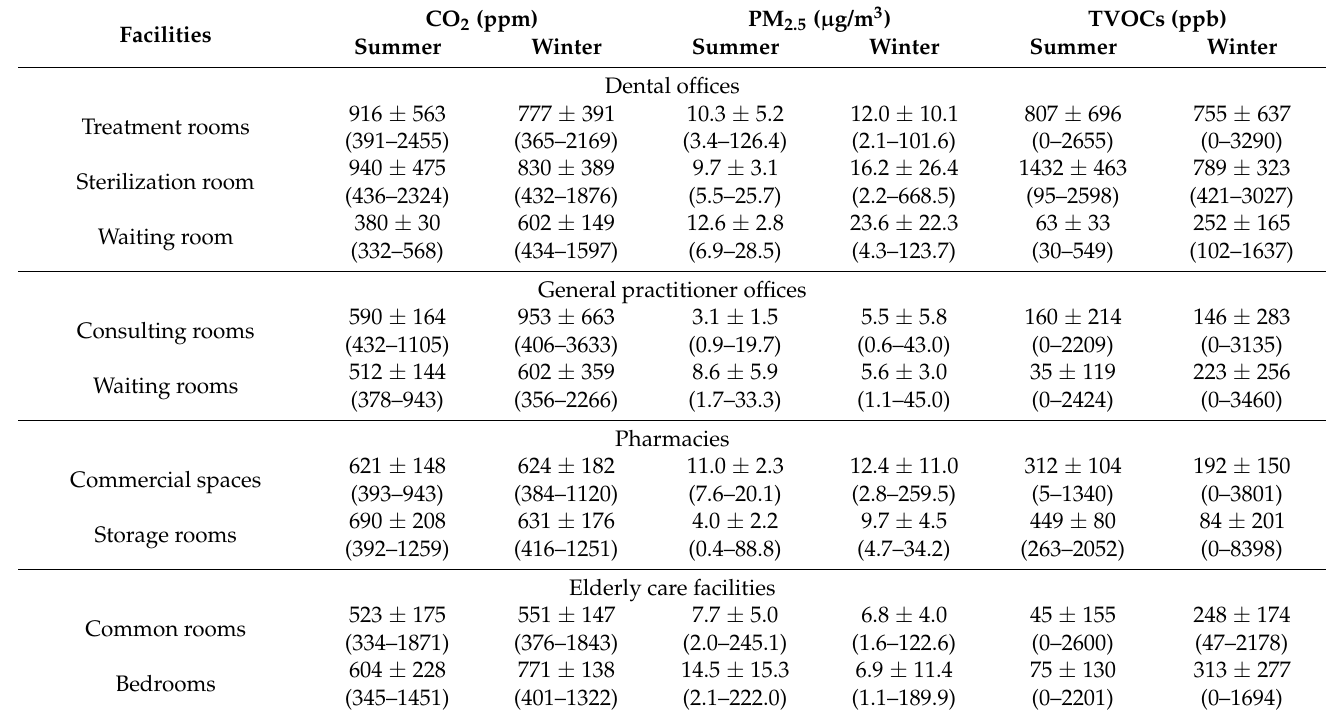
Table 2. Comparison of mean ± SD (min–max) concentrations of CO 2 , PM 2.5 and TVOCs measured in each type of room in private healthcare and elderly care facilities, according to the